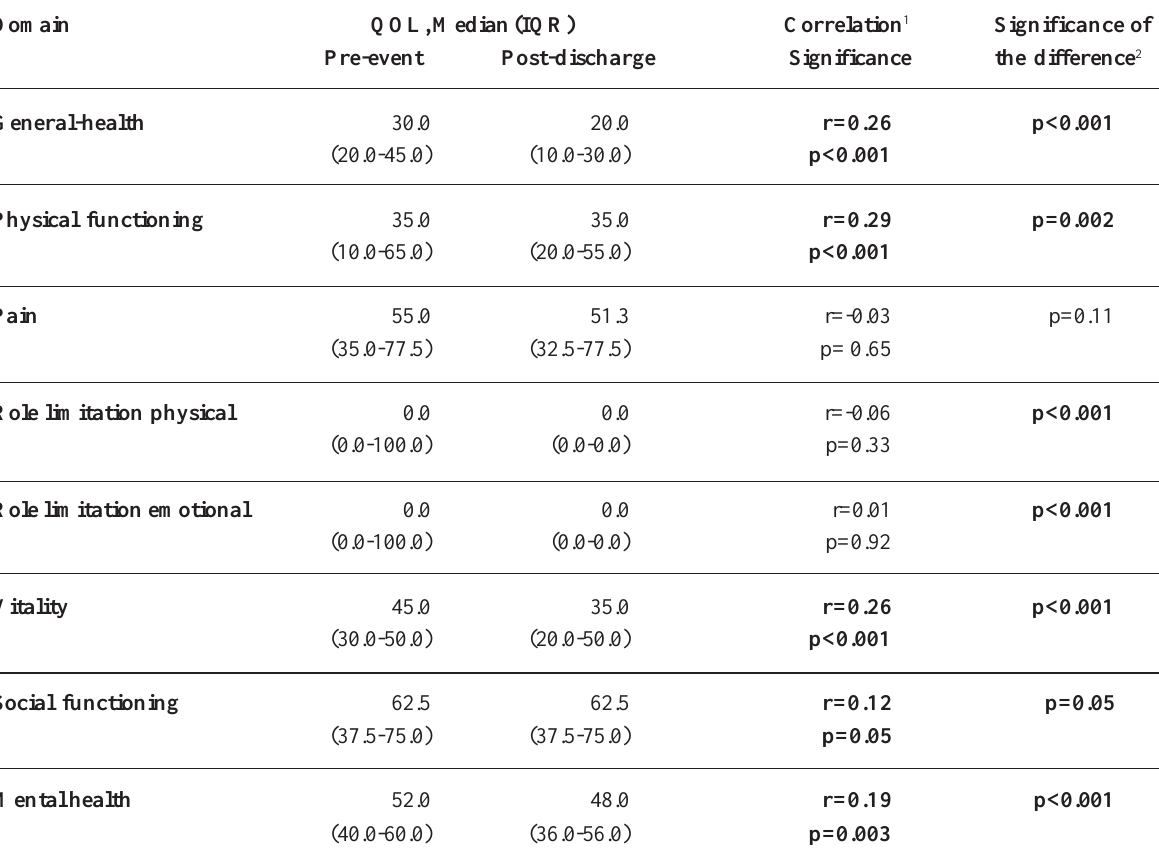
Table 1. Comparison of the pre-exacerbation and post-discharge QOL of COPD patients